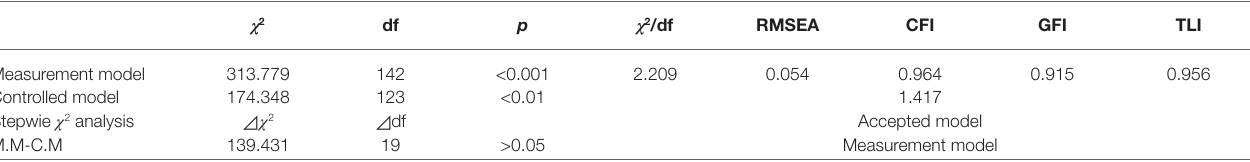
TABLE 2 | Analysis of common method bias.